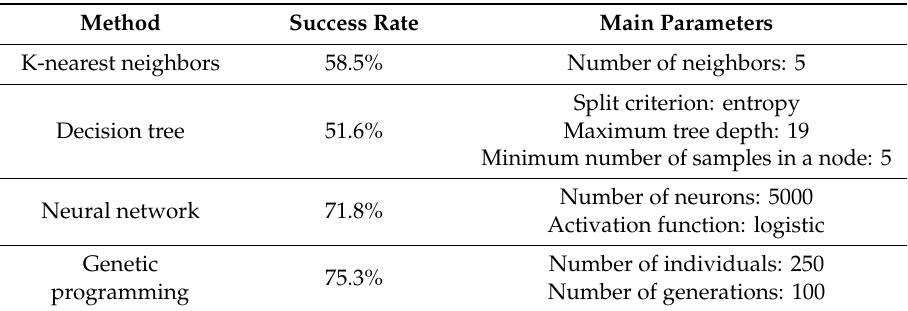
Table 1. Success rate and parameterization of the machine learning methods